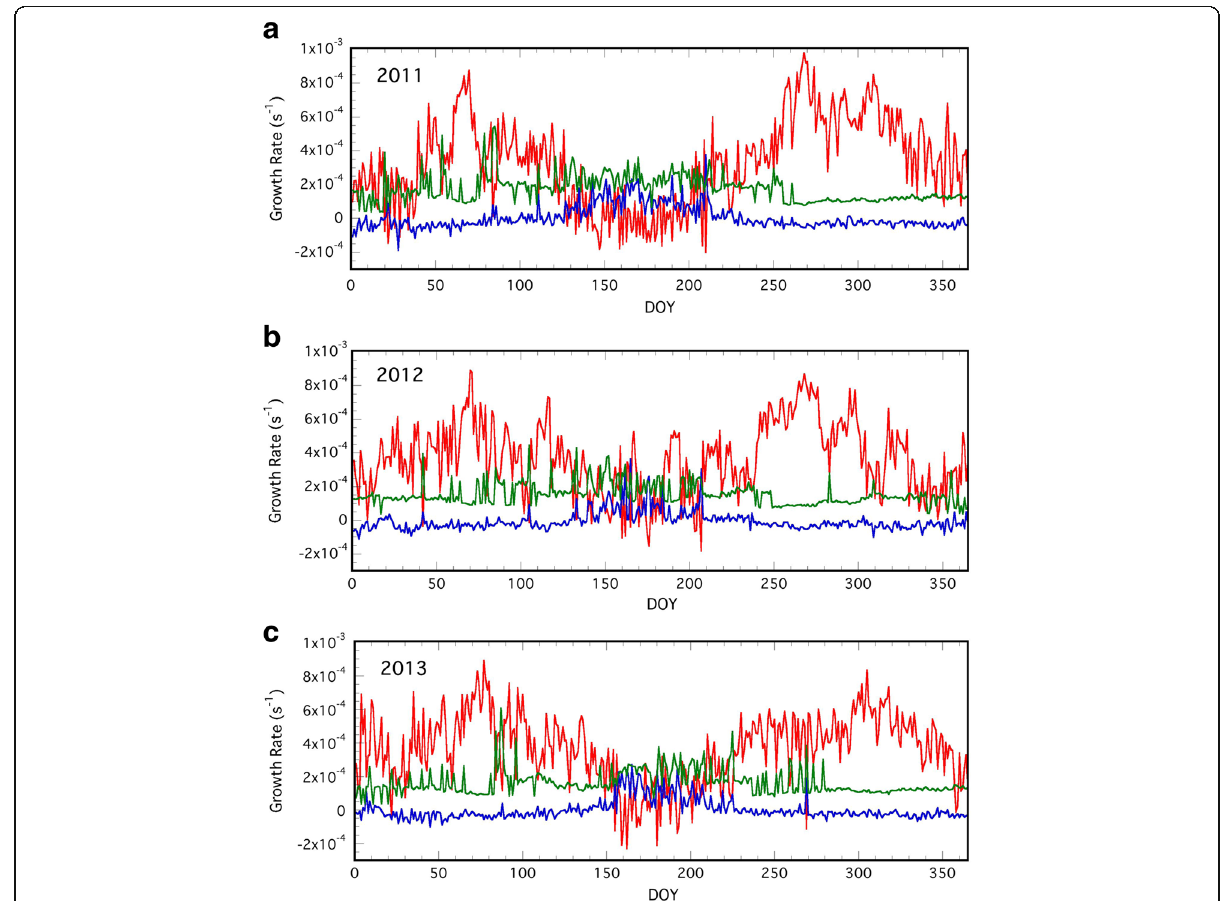
Fig. 5 Daily variations of various terms in the R-T growth rate. Individual terms in Eq. (1) in the R-T growth rate (Fig. 1) are shown for the years a 2011, b 2012, and c 2013. Lines indicate (red) upward ExB drift term, (green) gravity term, and (blue) vertical neutral wind